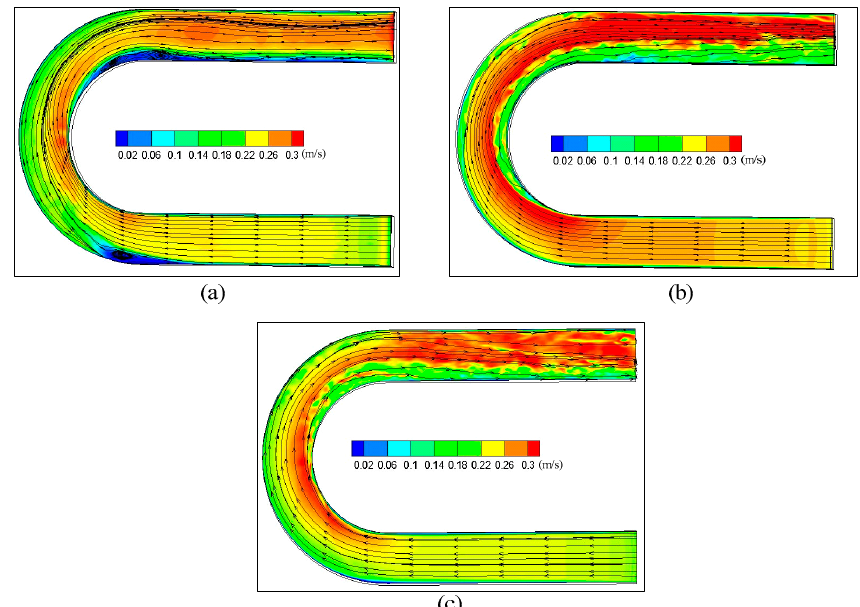
Figure 9. Velocity distribution and streamlines at different water depths: ( a ) z / H = 0.9; ( b ) z / H = 0.5; ( c ) z / H = 0.2.